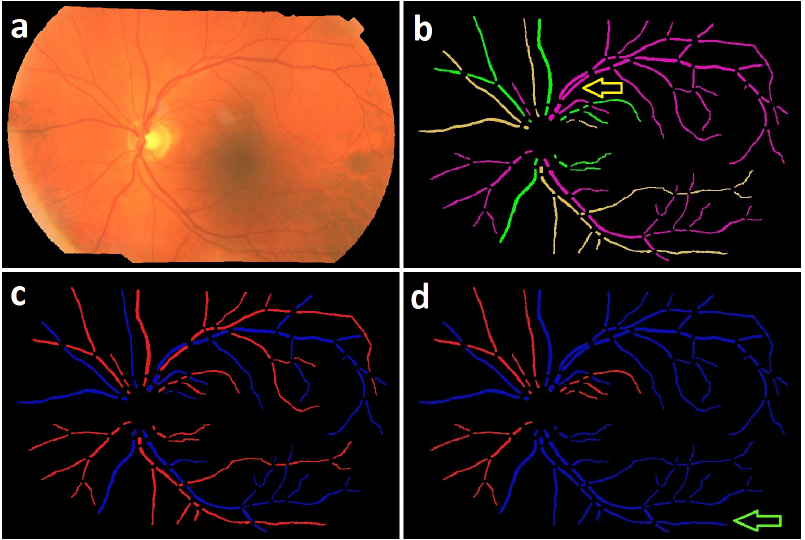
Figure 13. Image example: a) Fundus image b) Structural mapping c) Manual AV labeling d) Automated AV Classification.